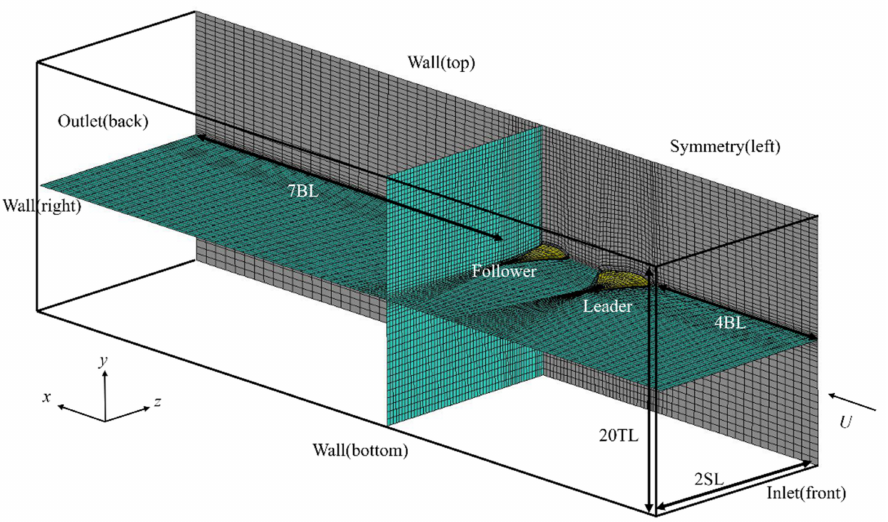
Figure 6. Computational domain size and boundary condition